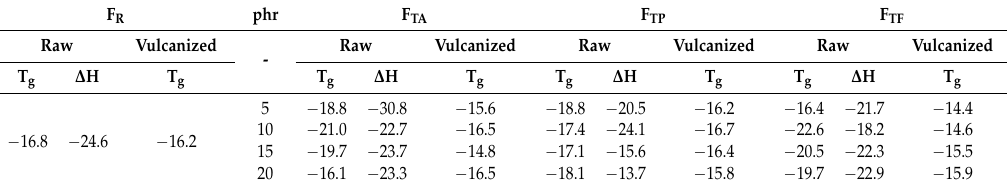
Figure 4. Differential Scanning Calorimetry (DSC) curves of raw and cured F T nanocomposites: ( a ) F TA , ( b ) F TP , and ( c ) F TF at a heating rate of 20 °C ∙ min − 1 . Table 1. Summary of T g and Δ H of the composites (T g and Δ H are reported in °C and J/g, respectively). F R phr F TA F R